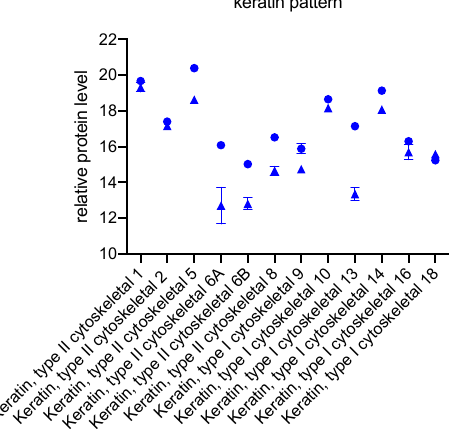
Figure 3. Significant specific expression of keratins in GK. Protein peak areas were transformed with a log2 scale, and bacterial conditions were compared pairwise with standard conditions using a Student’s t -test ( p < 0.05) and Benjamini-Hochberg correction for multiple tests.